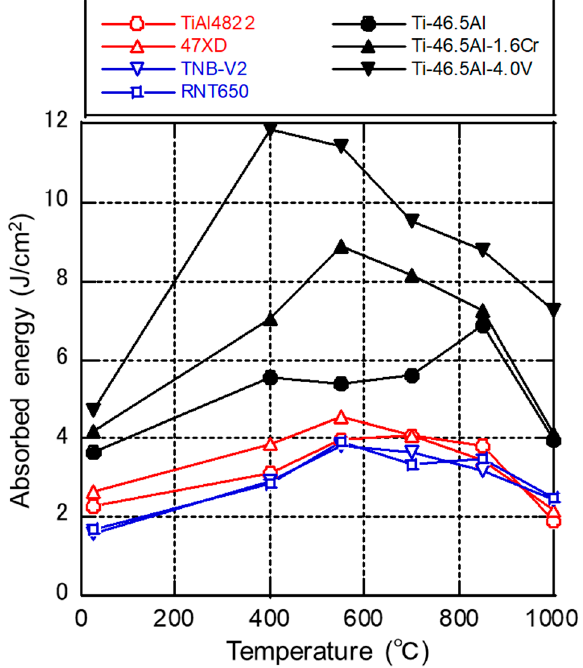
Figure 5. Comparison of average Charpy absorbed energies of the cast TiAl alloys at various temperatures.